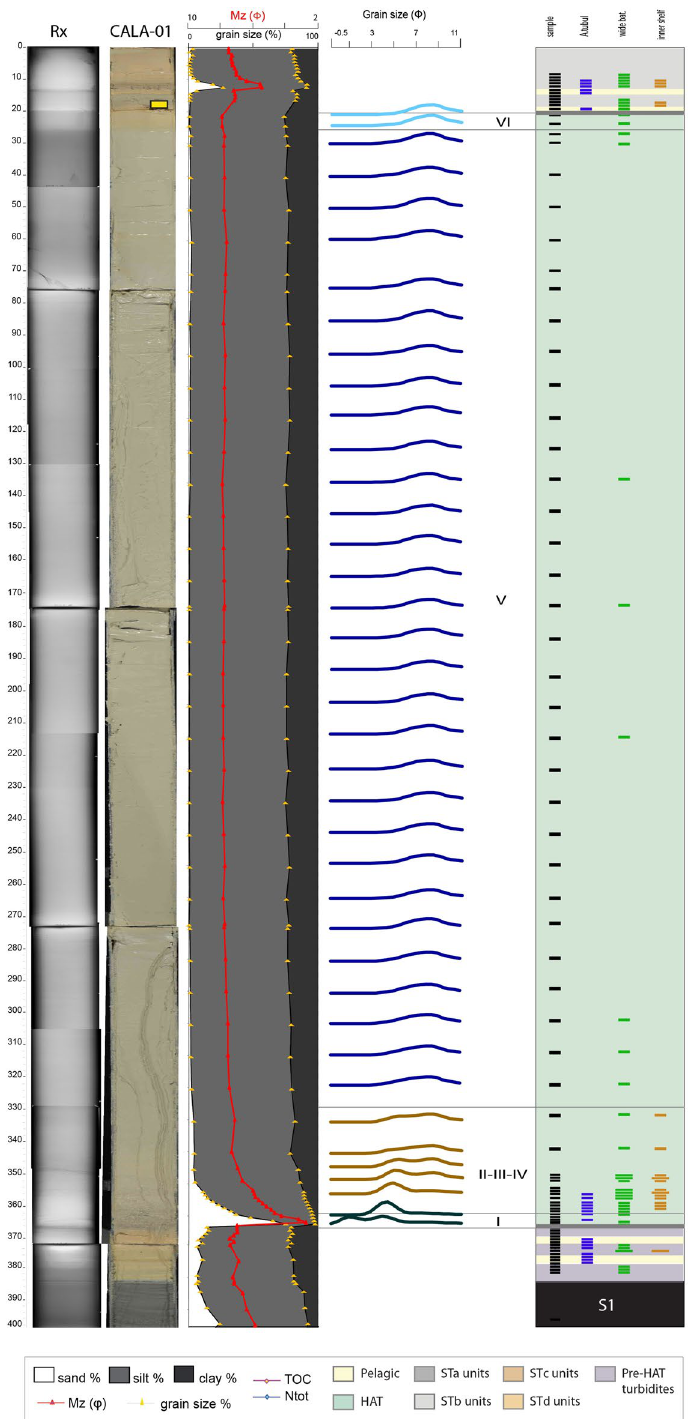
Figure 6. Log of core CALA-01. From left to right: CAT scan, photograph, grain size % with mean diameter in magenta, grain size modes in different colours for each sediment unit within the HAT, benthic foraminifera assemblages, subdivision in individual HAT units (I-VI) in green and pelagic units identified by different colors. Yellow rectangle on the CAT scan image, represents 14 C dated samples (SM1). Benthic foraminiferal assemblages are grouped in three different classes: blue = abyssal species (mainly A. tubulosa); green = wide bathymetric ranges; brown = inner shelf (see Table 2, SM6 and SM7 for more details). Thin sample rectangles represent 0,5 cm thick samples. Thick sample rectangles represent 1 cm thick samples. Small coloured rectangles = rare specimens: < 25 specimens in 0.03 g of sample; large coloured rectangles = common specimens: > 25 specimens in 0.03 g of sample (see Table 2 for details on the bathymetric